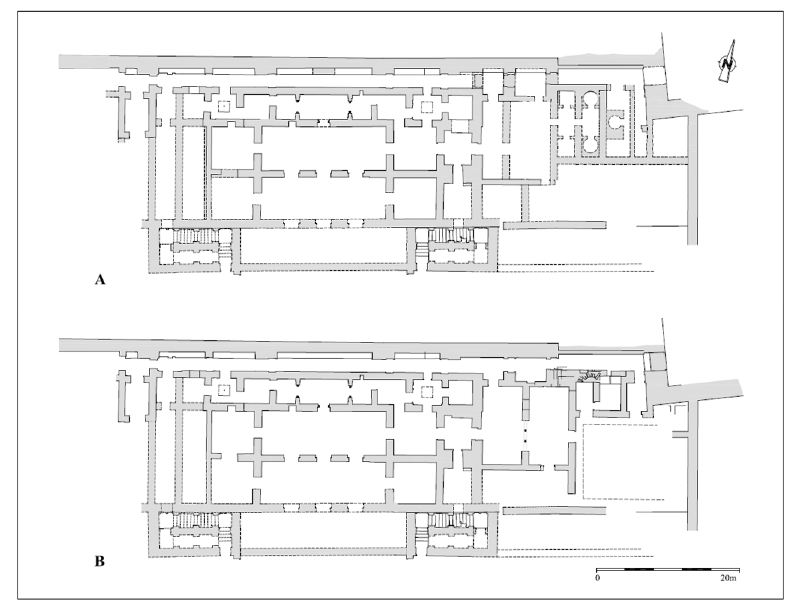
Figure 4. Construction phases of D¯ar al-Mulk : ( A ) first phase; ( B ) second phase (Vallejo Triano 2010, Figure 53-1).